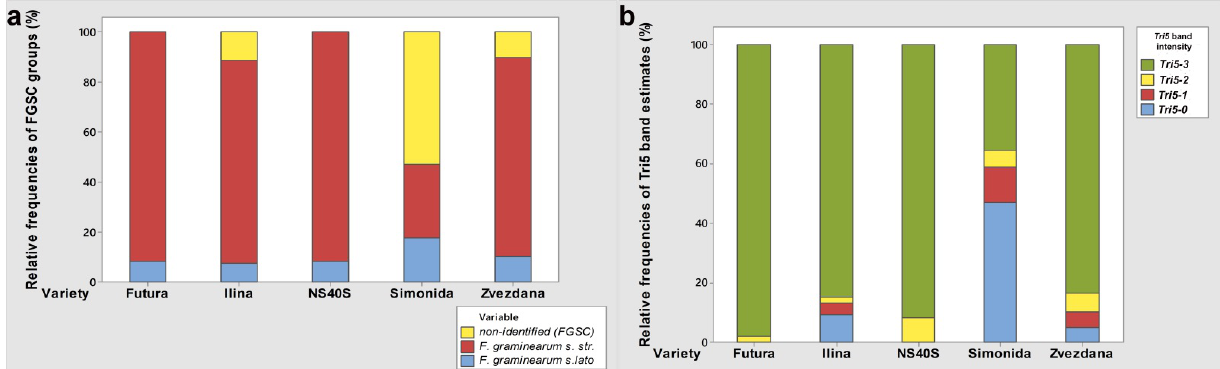
Figure 7. Association between five winter wheat varieties and FGSC groups and isolates differing in mycotoxin production potential. ( a ) Relative frequencies of F. graminearum s. stricto , F. graminearum s. lato, and nonidentified (FGSC) isolates in five winter wheat varieties; ( b ) relative frequencies of Tri5 DNA PCR products differing in band intensities and their associations with five winter wheat varieties.